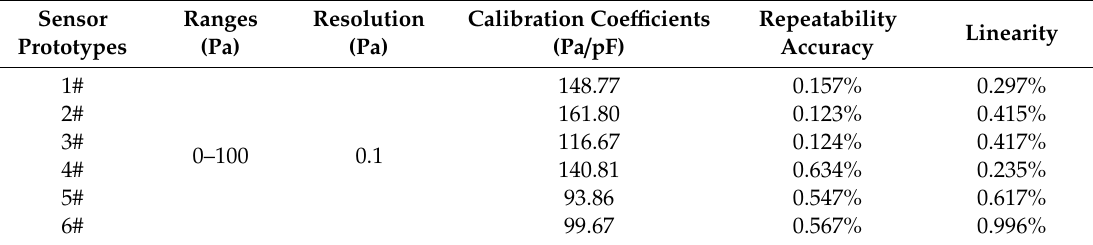
Table 2. The performance indexes of sensor prototypes static calibration.